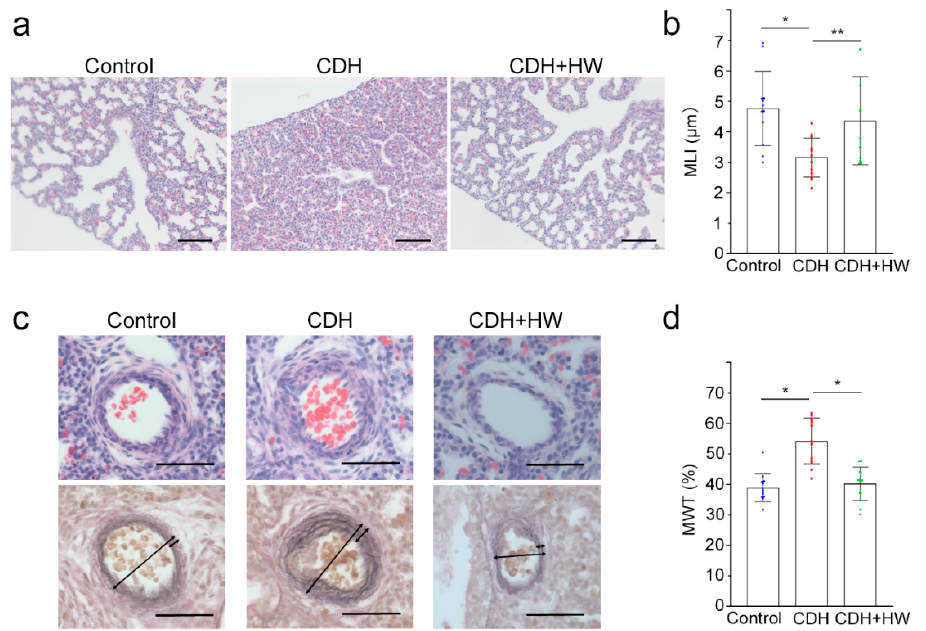
Figure 2. Alveolarization and pulmonary artery remodeling. ( a ) Representative images of the lungs stained with hematoxylin and eosin (HE). Original magnification, 200 × . Scale bars = 100 µ m; ( b ) The mean linear intercept (MLI) is shown for the control ( n = 12), CDH ( n = 13), and CDH + hydrogen-rich water (HW, n = 11) groups. Data are shown as mean ± standard deviation (SD).; ( c ) Representative images for pulmonary arteries stained with HE (upper panels) and Elastica Van Gieson (EVG, lower panels). Long and short arrows show measurements of the external diameter and wall thickness, respectively. Original magnification, 400×. Scale bars = 50 μ m; ( d ) Medial wall thickness (MWT, %) was calculated as (2 × wall thickness/external diameter) × 100. MWT is shown for the control, CDH, and CDH + HW groups (each group, n = 13). Data are shown as mean ± SD. * p < 0.01, ** p < 0.05